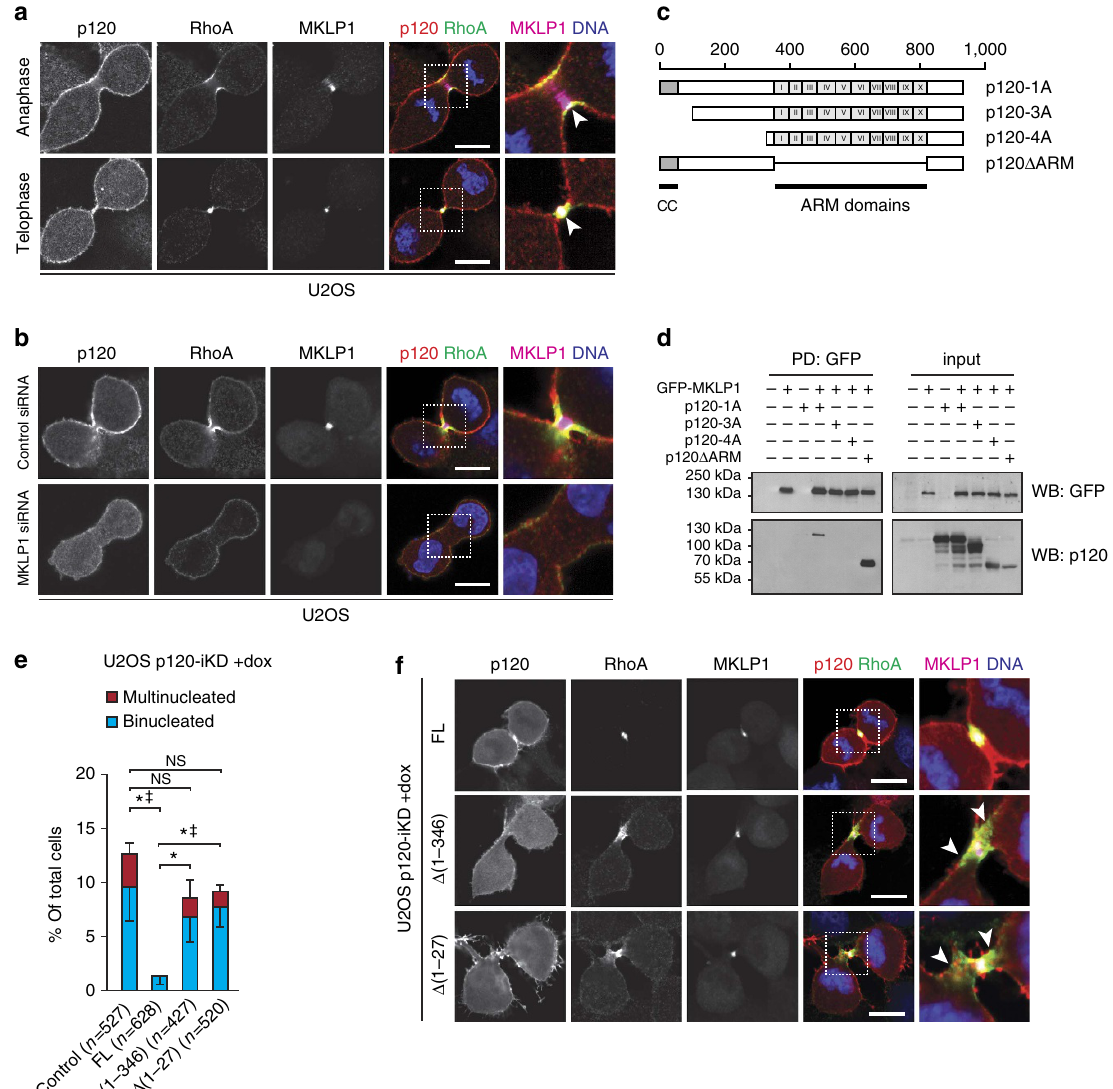
Figure 5 | p120 interacts with MKLP1 to regulate focused RhoA activity during cytokinesis. ( a ) IF for p120, RhoA and MKLP1 in anaphase and telophase U2OS. Note the co-localization of p120, RhoA and MKLP1 at the equatorial cortex (arrowheads). Right panels show representative magnifications of representative areas denoted by the dotted squares. Scale bar, 10 m m. ( b ) IF for p120, RhoA and MKLP1 in U2OS cells transfected with control and MKLP1-specific siRNAs. Right panels show magnifications of representative areas denoted by the dotted squares. Scale bar, 10 m m. ( c ) Overview of the different p120 constructs used. CC ¼ coiled-coil domains, ARM ¼ Armadillo. Scale bar denotes the amino acid position. ( d ) Western blot showing the co-immunoprecipitations for GFP-MKLP1 and p120 constructs described in c . ( e ) Quantification of bi- and multinucleation in dox-treated U2OS p120-iKD reconstituted with empty vector (control), FL p120-1A, p120-1A D [1–346], and p120-1A D [1–27]. Statistical significance was determined using the Student’s t -test. Shown are the data from three independent experiments. Results are expressed as mean ± s.d. * P o 0.05/ z P o 0.05 (binucleation and multinucleation, respectively). ( f ) IF for p120, RhoA and MKLP1 in dox-treated U2OS p120-iKD cells reconstituted with FL p120-1A, p120-1A D [1–346]